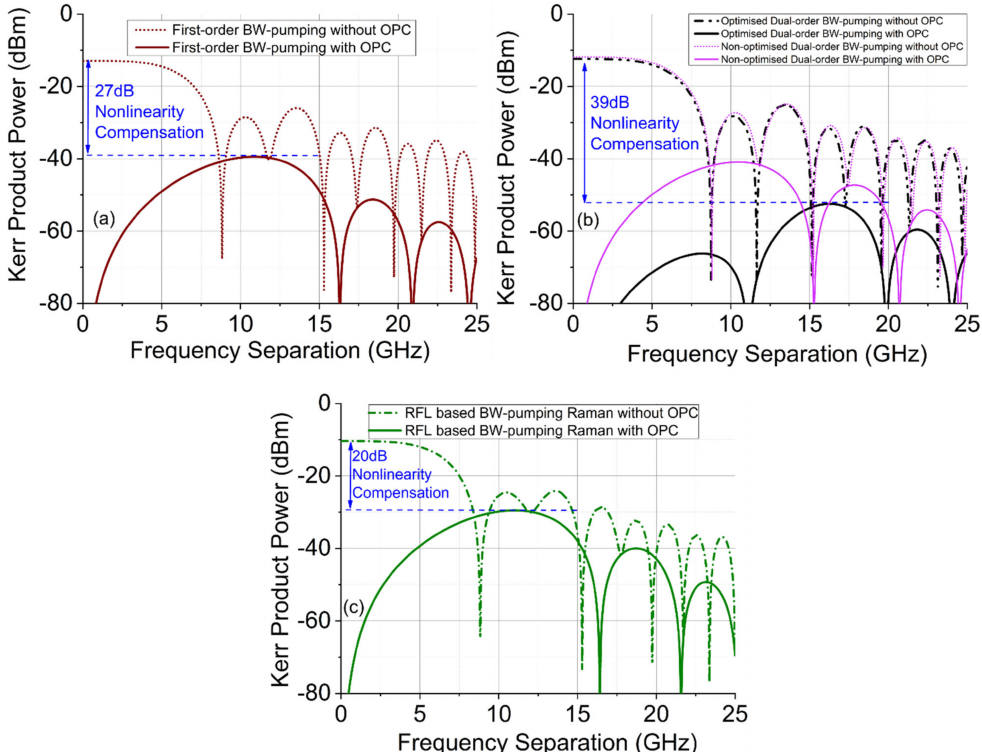
Figure 5. Theoretical predication of nonlinear Kerr product power as a function of frequency separa- tion between the two CW lasers over 50 km SSMF. ( a ) First-order Raman amplification. ( b ) Dual-order Raman amplification with optimized pump power and non-optimized pump power). ( c ) Random Raman-fiber-laser-based